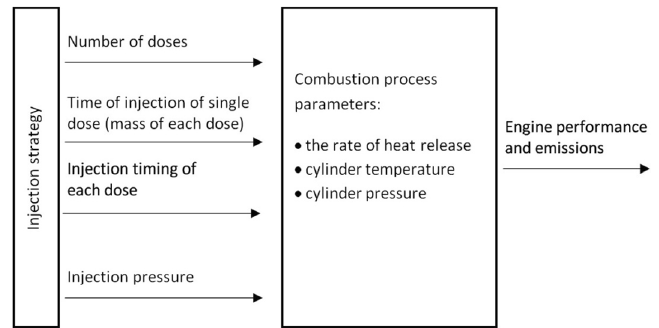
Figure 1. The control of combustion realised by the Engine Control Unit (ECU). (Source: